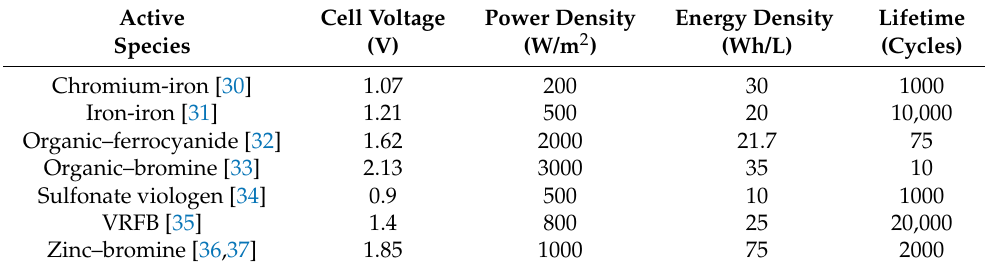
Table 2. Comparison of different RFB systems based on their active species. Extracted from [28,29]. Active Cell Voltage Power